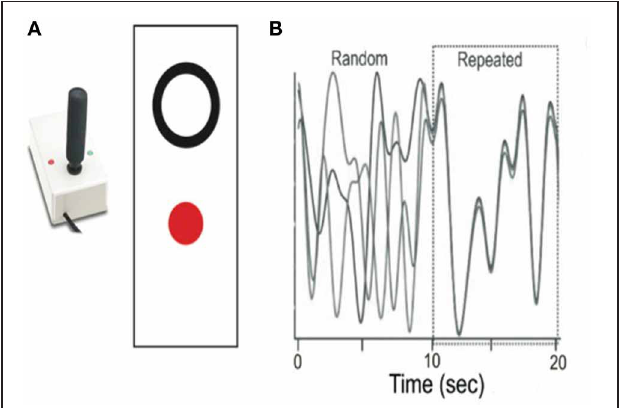
FIGURE 1 | Overview of experimental task and sample repeated and random segments. (A) A non-ferrous joystick was used for tracking; individuals were asked to move the joystick to place the red dot in the white circle. (B) Sample repeated and random segments from the CT